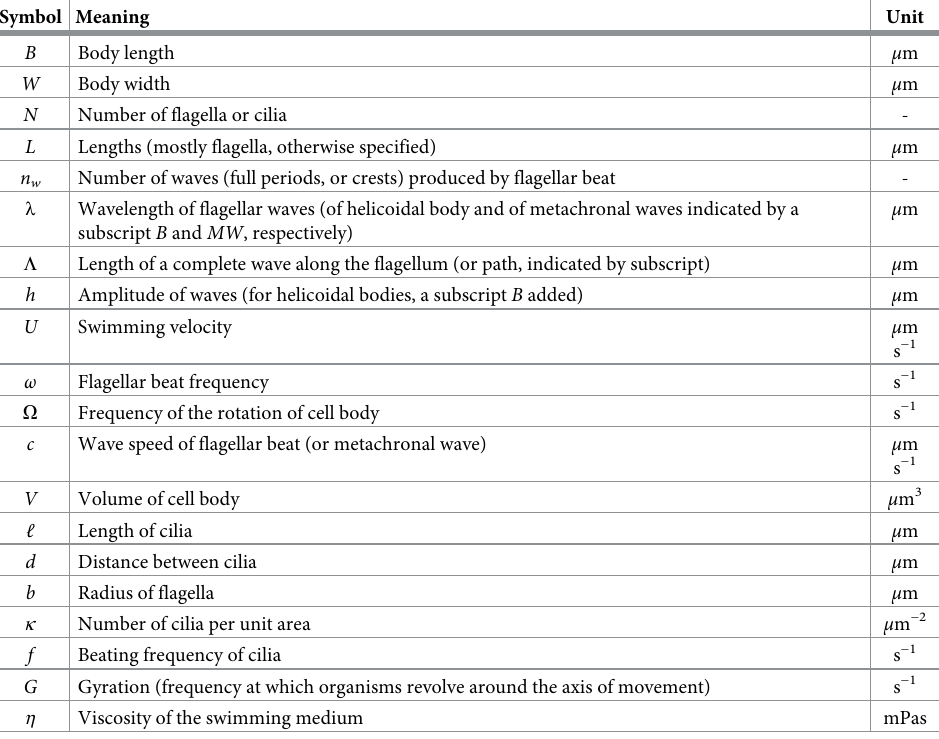
Table 3. List of symbols used in the database, together with their explanation and units. Symbol Meaning Unit B Body length μ m W Body width μ m N Number of flagella or cilia - L Lengths (mostly flagella, otherwise specified) μ m n w Number of waves (full periods, or crests) produced by flagellar beat - λ Wavelength of flagellar waves (of helicoidal body and of metachronal waves indicated by a subscript B and MW , respectively) Λ Length of a complete wave along the flagellum (or path, indicated by subscript) μ m h Amplitude of waves (for helicoidal bodies, a subscript B added) μ m U Swimming velocity μ m ω Flagellar beat frequency s − 1 O Frequency of the rotation of cell body s − 1 c Wave speed of flagellar beat (or metachronal wave) μ m V Volume of cell body μ m 3 ℓ Length of cilia μ m d Distance between cilia μ m b Radius of flagella μ m κ Number of cilia per unit area μ m − 2 f Beating frequency of cilia s − 1 G Gyration (frequency at which organisms revolve around the axis of movement) s − 1 η Viscosity of the swimming medium